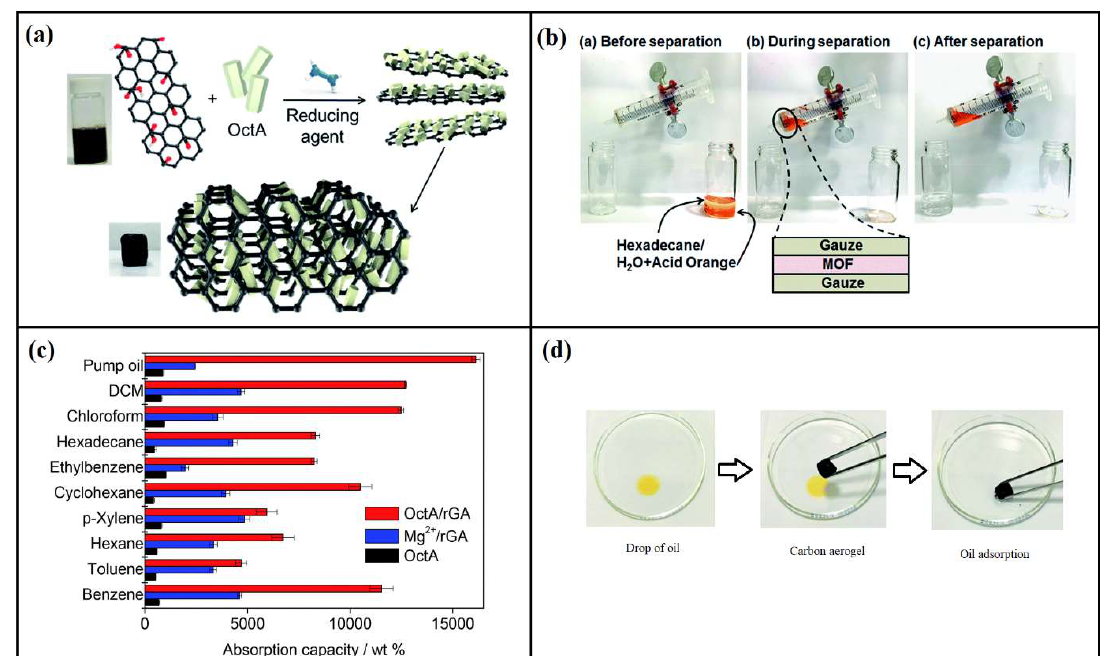
Figure 8. Illustration of octylamine reduced graphene oxide aerogel fabrication for oil/water sepa- ration. ( a ) the fabrication process, ( b ) organic solvent separation experiment, ( c ) absorption of dif- ferent organic solvents and dyes, ( d ) absorption performance of the aerogel. Reproduced with per- mission from Eom et al. [121] .